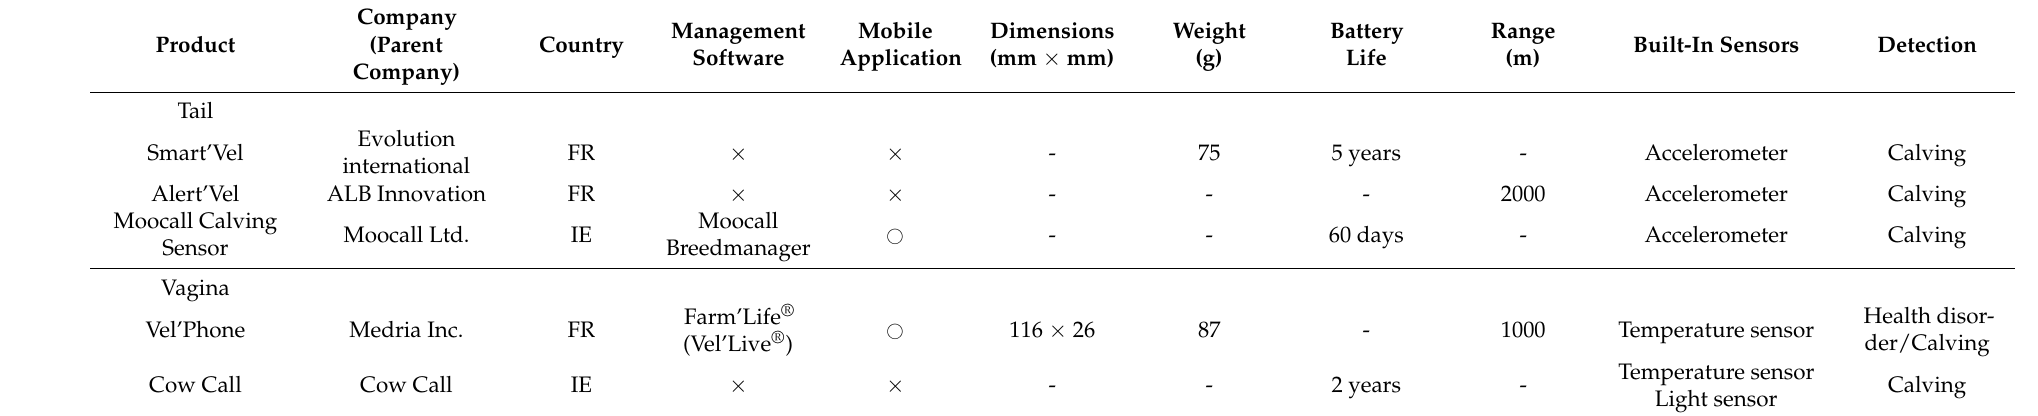
Table 9. Information about currently available tail- and vaginal-mounted type